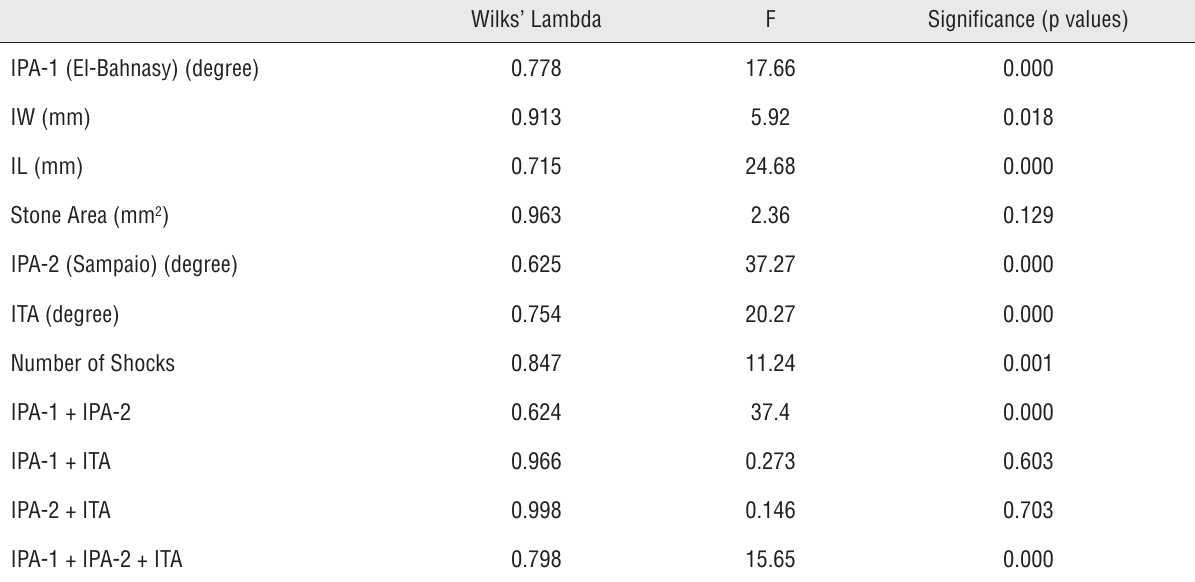
Table 2 - Significance status of variables.